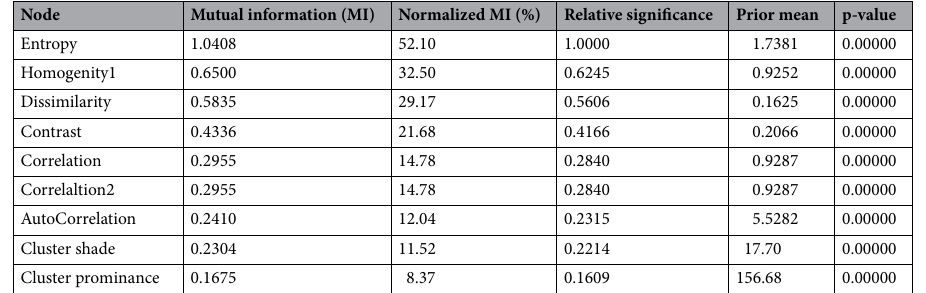
Table 4. Overall analysis of target node energy with other extracted GLCM features.